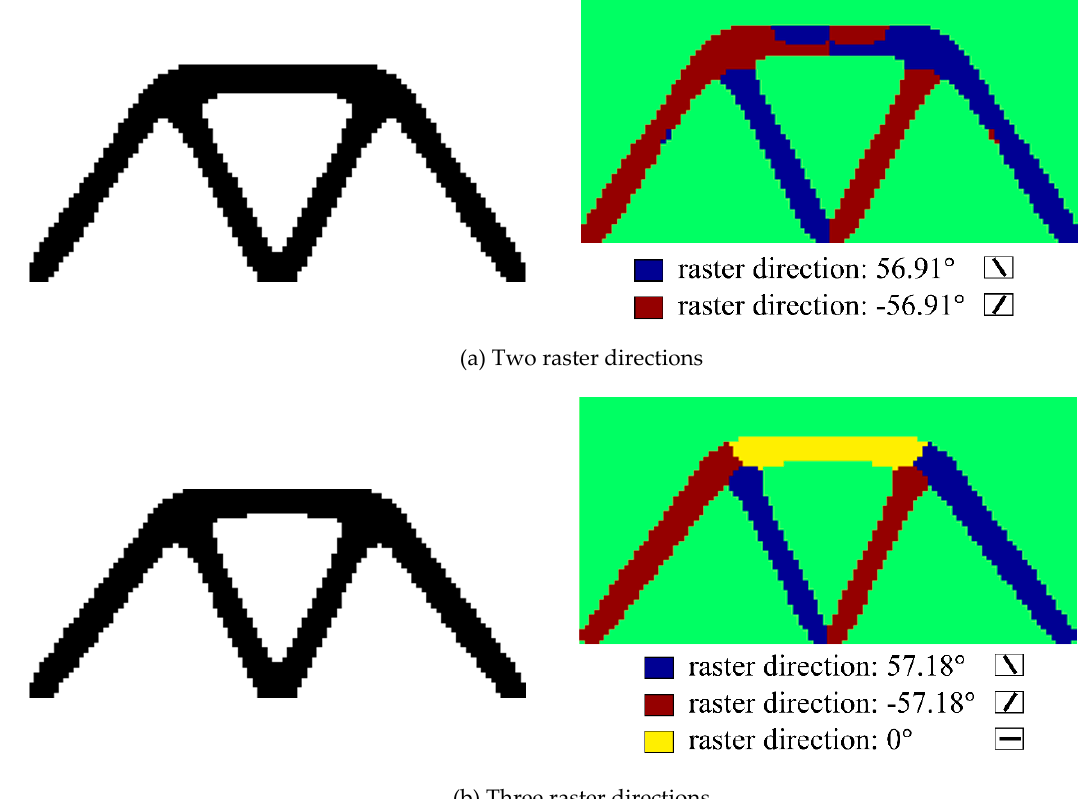
= 𝟏 , the red color 𝟏 = 𝟏 , and the green color 𝟑